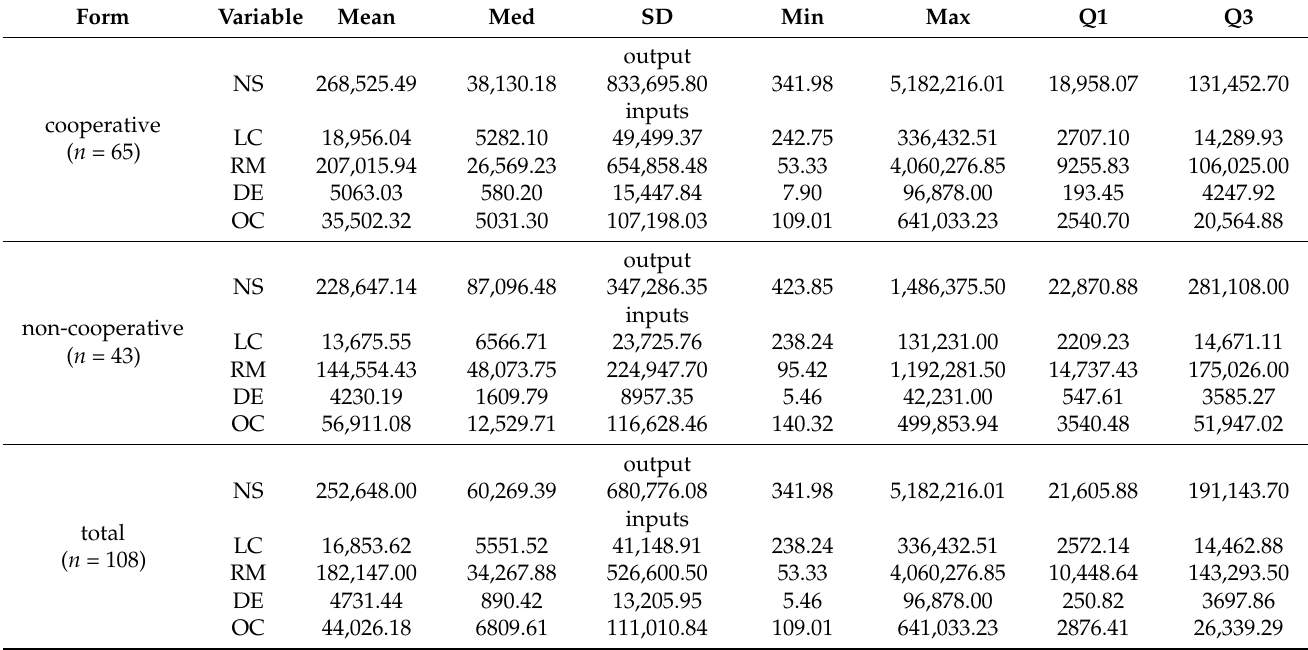
Table 2. Descriptive statistics of output and input variables; values given in thousands PLN (authors’ calculations based on